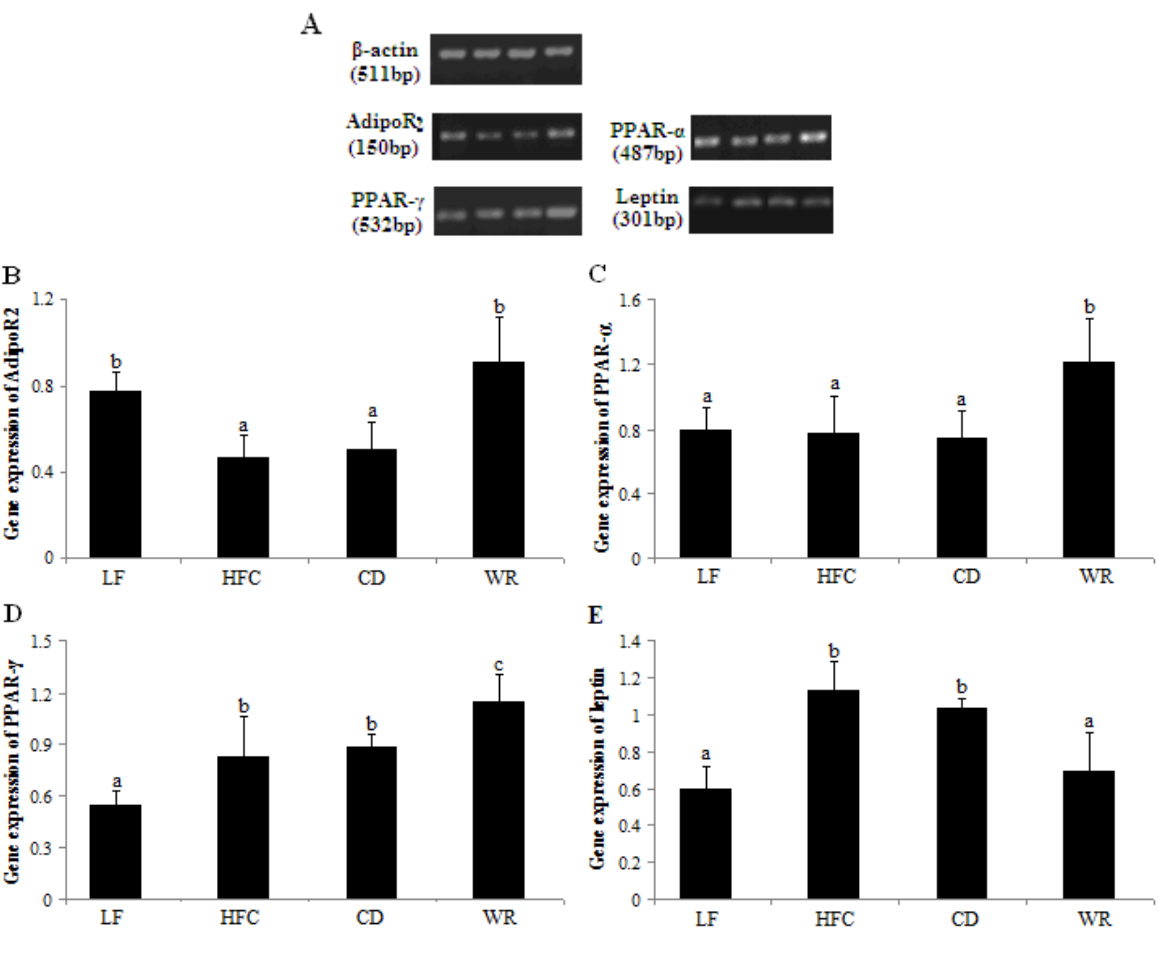
Figure 2. Relative mRNA abundance of AdipoR ( A ), PPAR-α ( B ) and PPAR-γ ( C ) in 2 liver tissues and leptin ( D ) in epididymal tissues of rats fed with different experimental diets. The steady-state mRNA levels of AdipoR , PPAR-α, PPAR-γ and leptin were 2 quantified with RT-PCR and normalized against β-actin. Values are expressed as the mean ± SD for five rats. Bars without a common superscript letter indicate significant differences among groups at p < 0.05. LF: low-fat diet; HFC: high-fat/cholesterol diet; CD: city diet; WR: wild rice